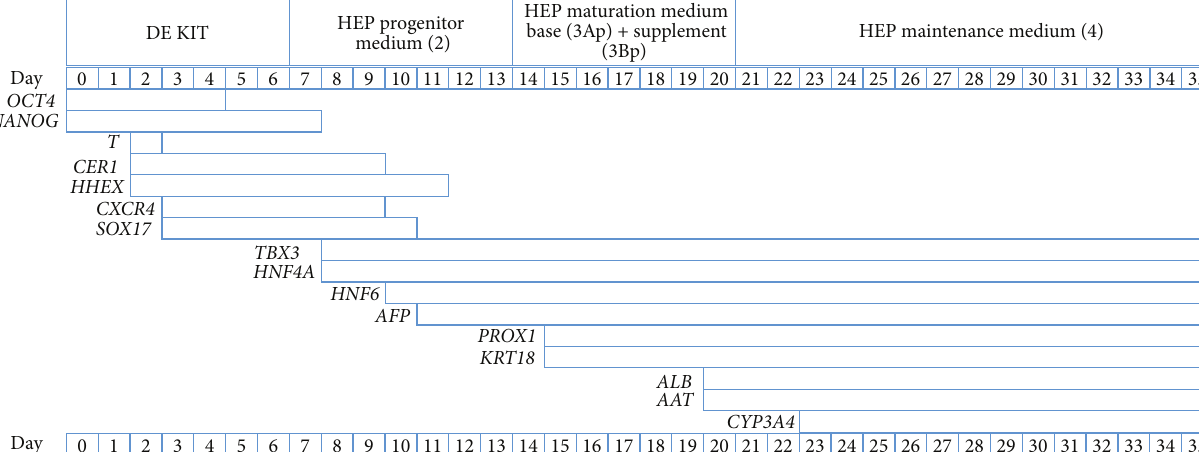
Figure 13: Overview of the expression patterns of all genes analyzed in this study. The header bar shows the medium in which the cells were incubated during the indicated days through hepatic differentiation. The bars below indicate the expression duration of the different genes during the hepatic differentiation. Gene expression after day 35 was not analyzed; hence end of expression for genes expressed at day 35 should not be assumed.